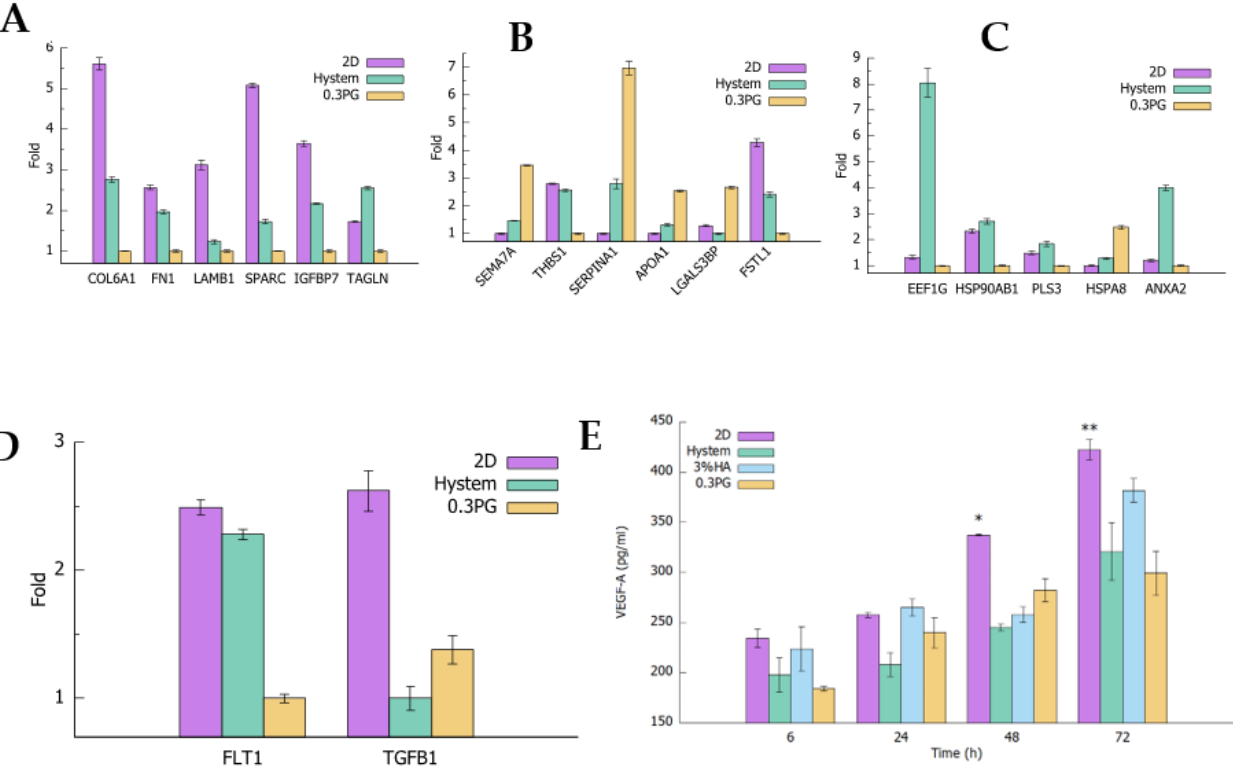
Figure 4. Analysis of the secretome of hADMSCs in Hystem and 0.3%PG encapsulations and 2D matrix. ( A – D ) Mass Spectrometry results of protein abundance expressed as fold change using the sample with lowest abundance of each protein as the reference. Representative proteins identified with high confidence ( ≥ 10 unique peptides) are grouped into 3 categories: extracellular matrix (ECM) and ECM binding proteins ( A ); immune-response-related proteins ( B ); intracellular proteins ( C ) Folds of Vascular endothelial growth factor receptor-1 (VEGFR1/FLT1) and transforming growth factor beta-1 (TGF β 1) are shown in ( D , E ) Levels of VEGF-A released by hADMSCs in 2D or